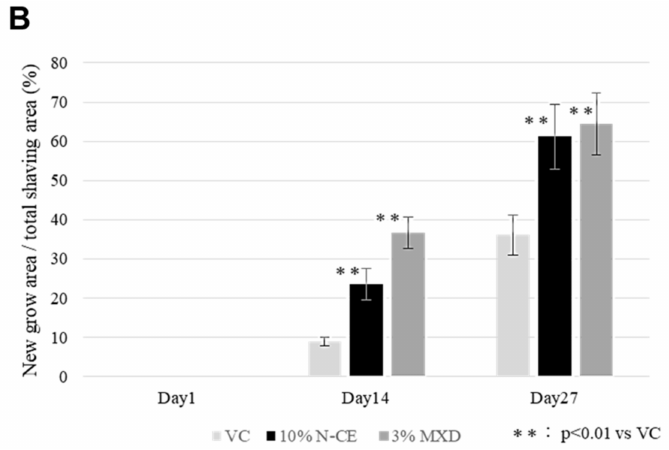
Figure 1. ( A ) The promotion of hair growth in C57BL/6N mice. VC (propylene glycol: ethanol: water (5:3:2)) and N-CE, MXD were applied to the back skin of C57BL/6N male mice for 27 days and the effect on hair growth was observed. ( B ) The area of newly grown hairs was measured by ImageJ. The x-axis represents time and the y-axis represents the area of newly grown hairs as a percentage of the total area. Results were presented as mean ± SD ** p < 0.01 when compared to the respective VC values by Student’s t -test (n = 6).